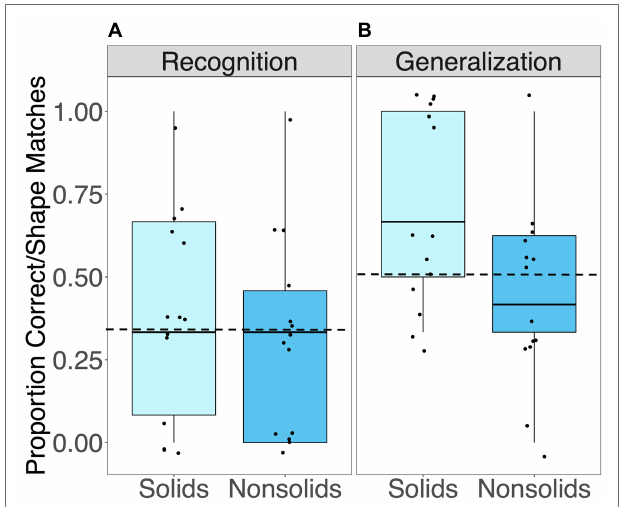
FIGURE 4 | Average (A) proportion correct on recognition trials testing children’s associations between novel words and objects, and (B) proportion shape matches selected on generalization trials testing children’s attention to shape and material. Dashed lines represent chance (0.33 and 0.50 for the tests of recognition and generalization